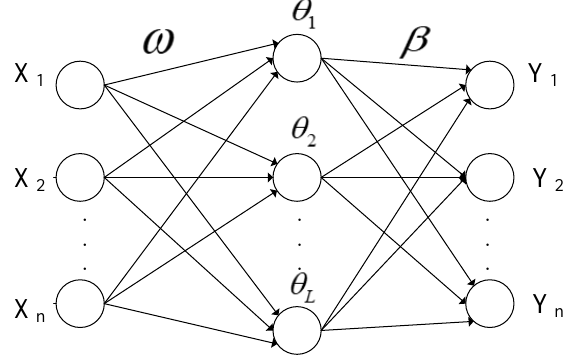
Figure 1. Network structure diagram of an ELM.